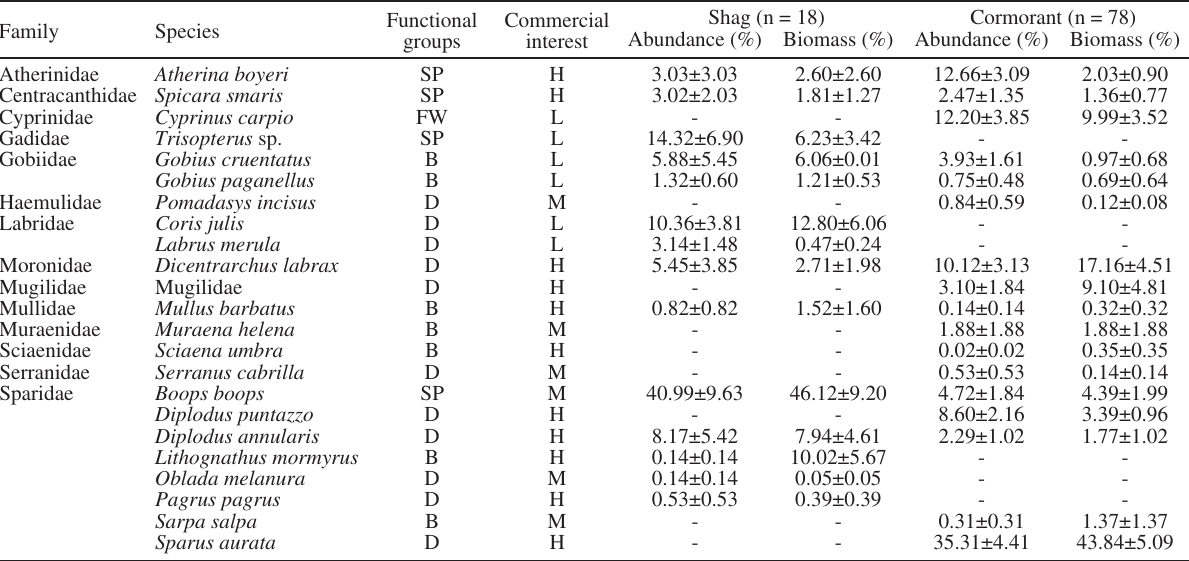
Table 1. – Species composition obtained from shag and great cormorant pellet analysis, expressed in terms of abundance and biomass as % with respect to the total (mean±standard error), and assignation of fish species to functional groups (SP, small pelagic; B, benthic; D, demersal; FW, freshwater) and commercial interest (H, high; M, medium; L, low)